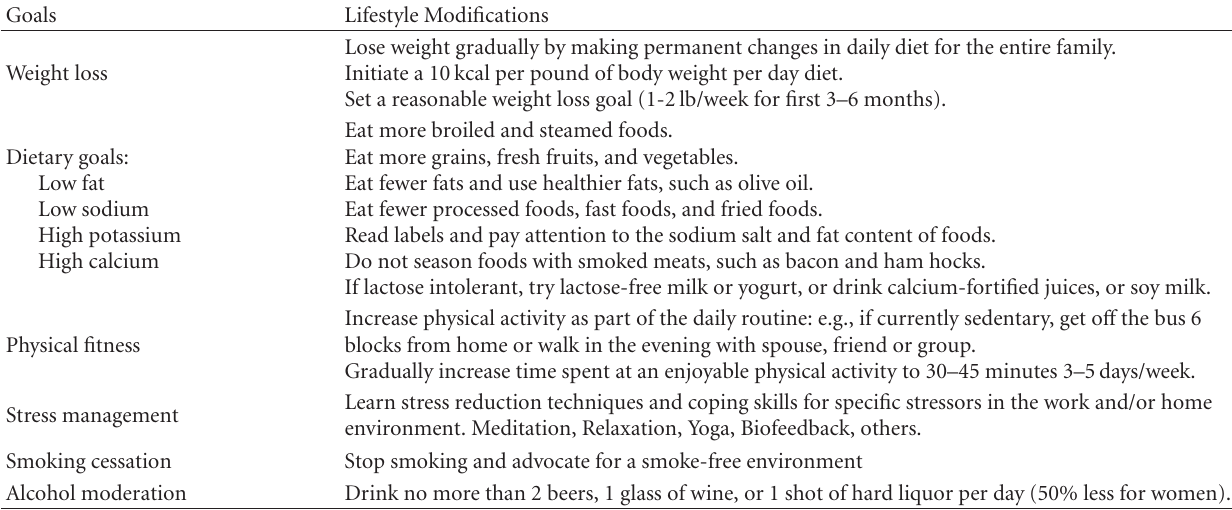
Table 3: Life style modifications for cardiovascular risk